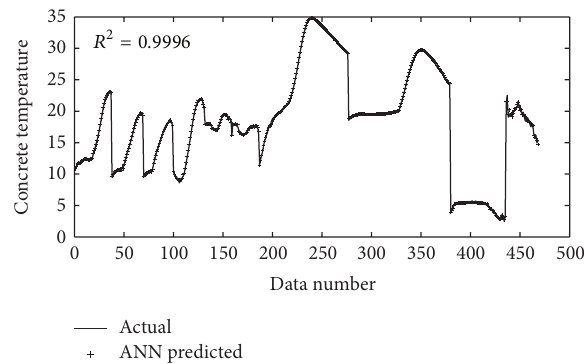
Figure 4: Graphical comparison of temperature with those pre- dicted by ANN in the validation process.